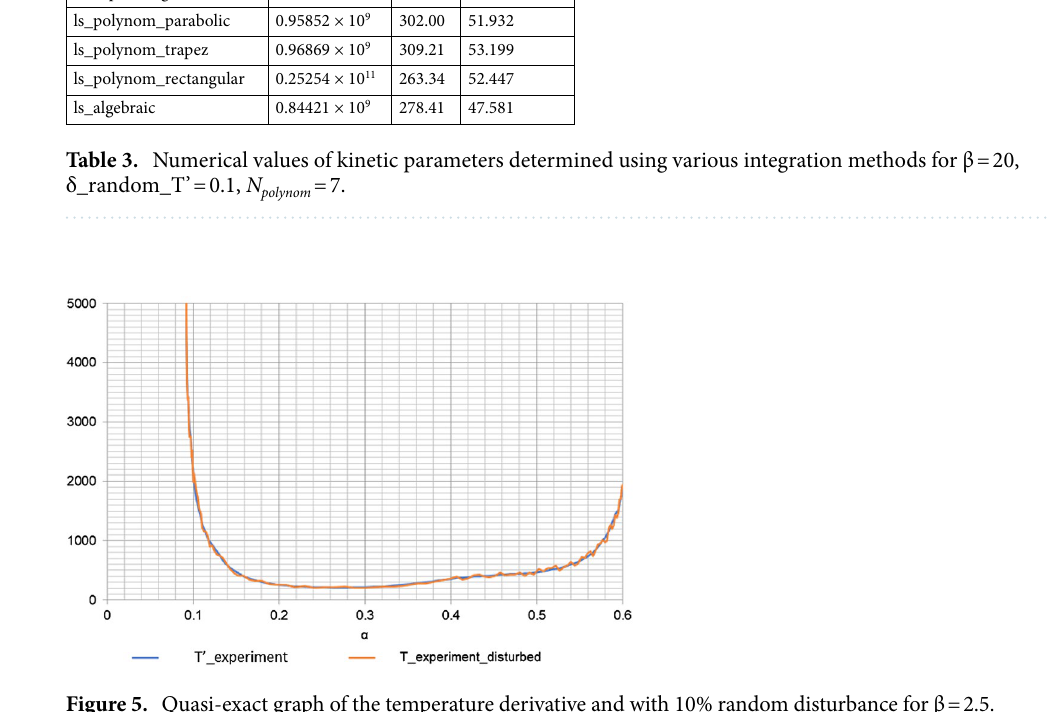
Figure 5. Quasi-exact graph of the temperature derivative and with 10% random disturbance for β =